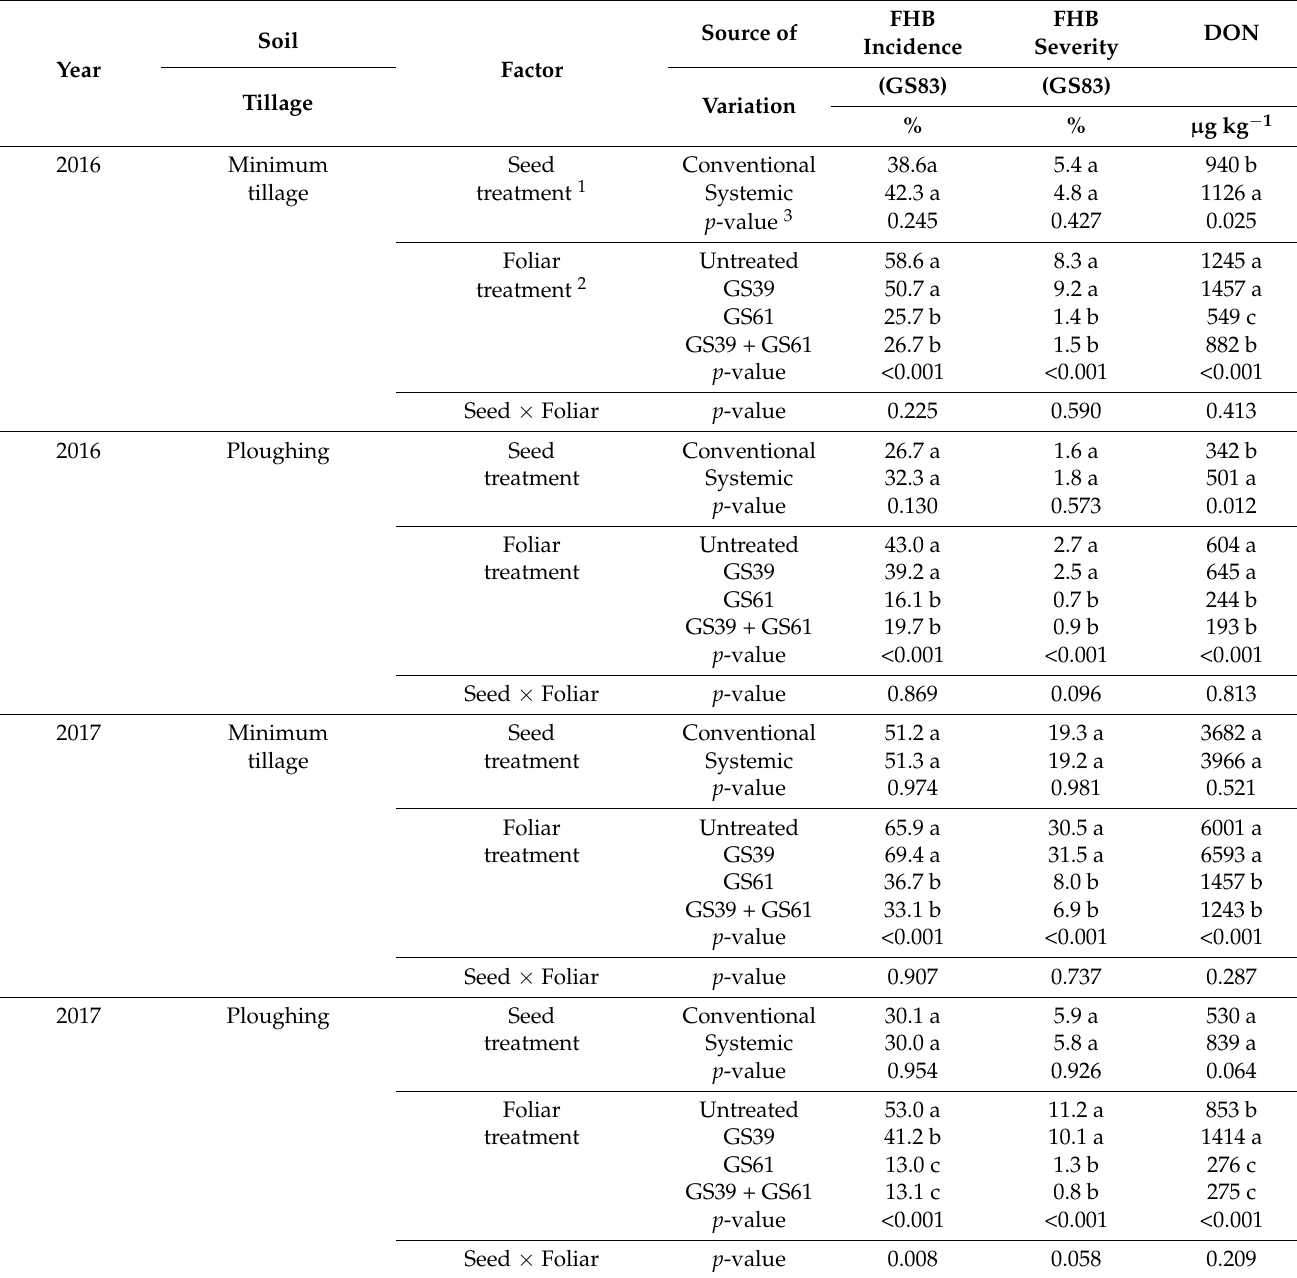
Table 3. Effect of the fungicide seed and foliar treatments on Fusarium Head Blight (FHB) incidence and severity at the early dough stage (GS83) and on deoxynivalenol (DON) content in the 2015–2016 and 2016–2017 growing seasons in